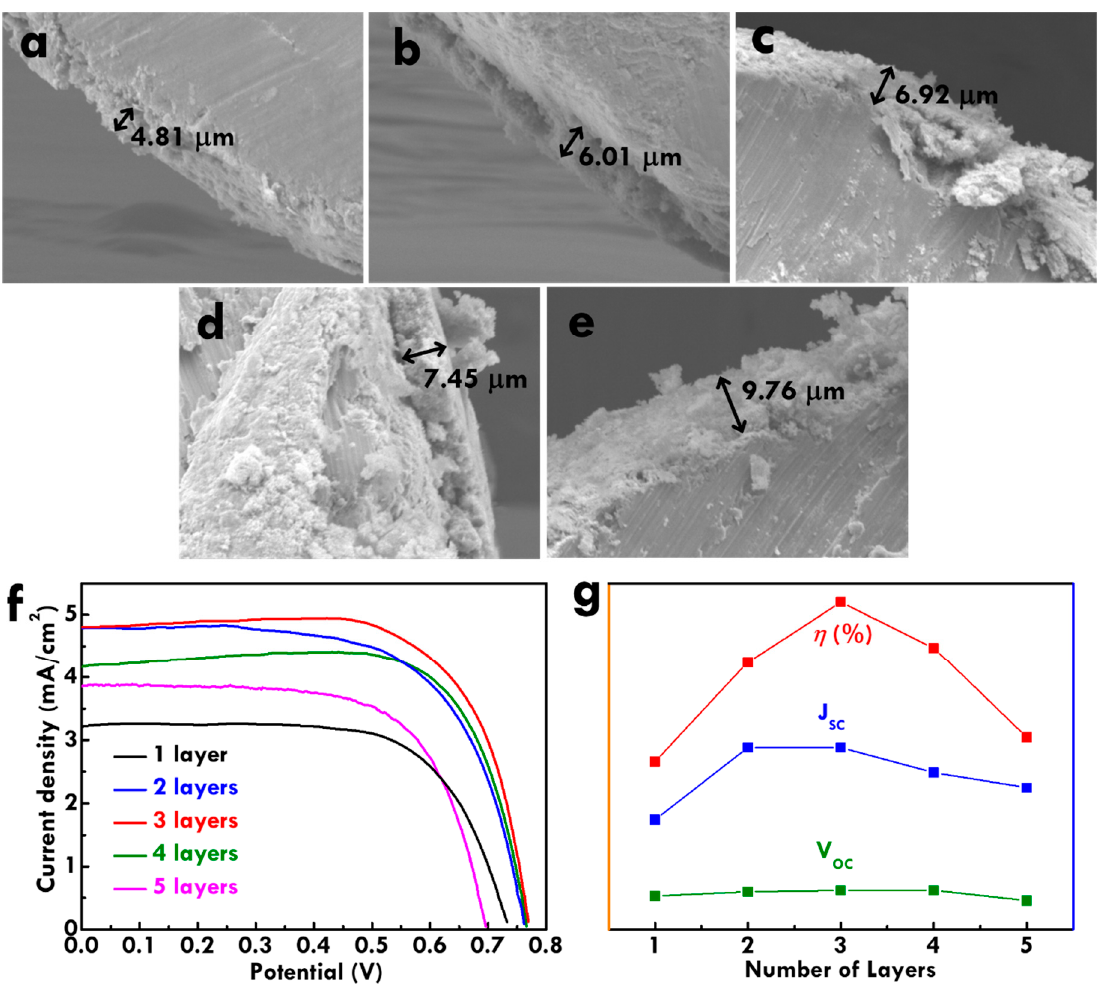
Figure 1. The SEM images for the TiO 2 nanoparticles (TNP)/Ti wire prepared using ( a ) one, ( b ) two, ( c ) three, ( d ) four, and ( e ) five layers; ( f ) the linear sweep voltammetry (LSV) curves and ( g ) the relation of the photovoltaic parameters to the number of TNP layers for the fiber-type dye-sensitized solar cells (FDSSCs) with the TNP/Ti wire photoanodes prepared using different TNP layers.